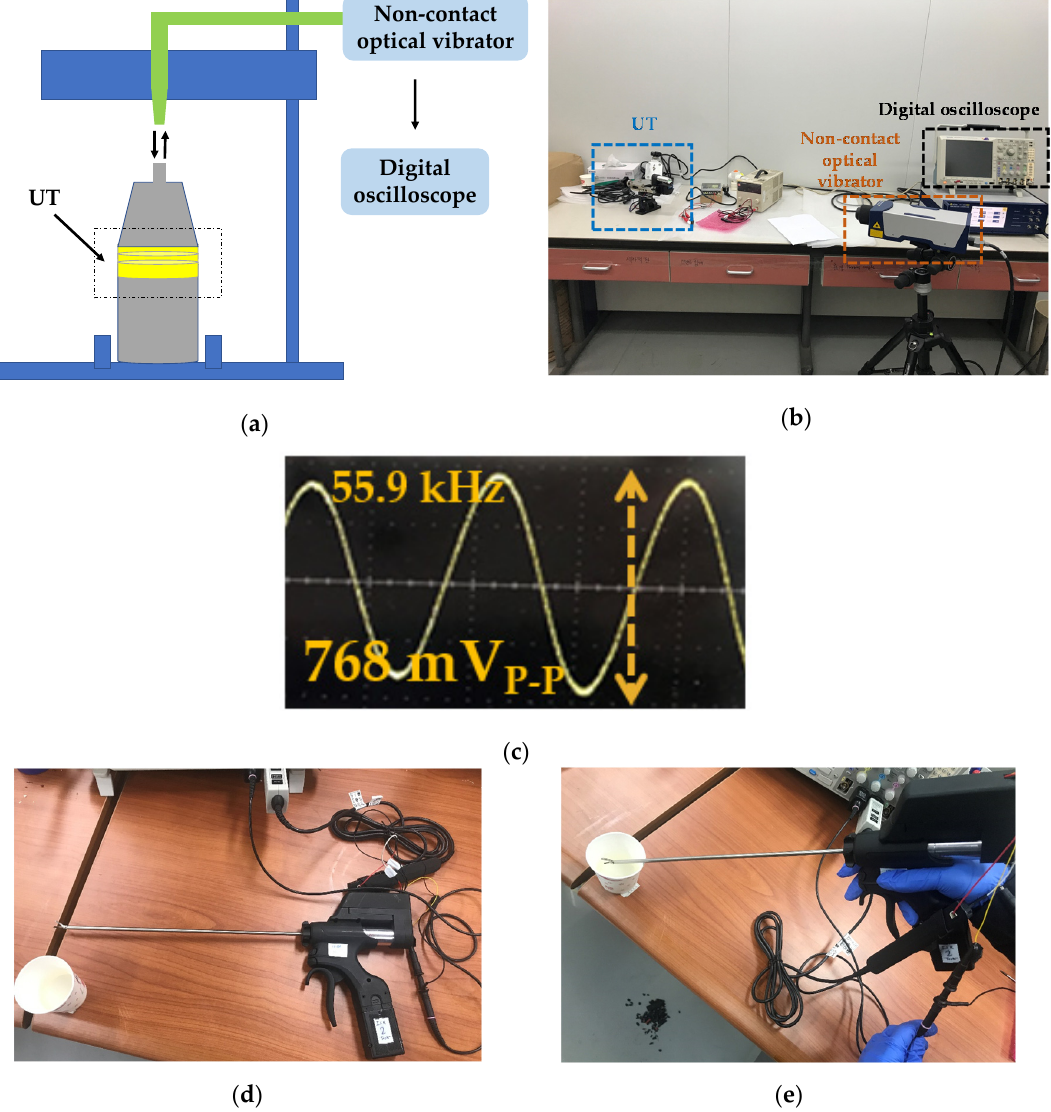
Figure 9. ( a ) Setup and ( b ) picture for the performance evaluation of the maximum amplitude and ( c ) measured maximum amplitude in the digital oscilloscope. ( d ) Setup for the performance evaluation of the applicable frequency ranges and ( e ) performance evaluation for power consumption reduction of the generator output.